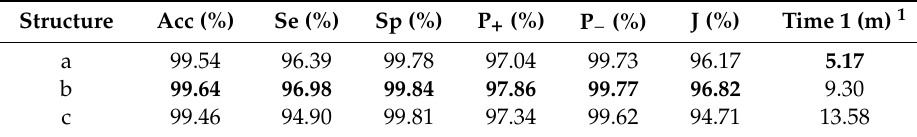
Table 6. The details and results of the varying size and number of